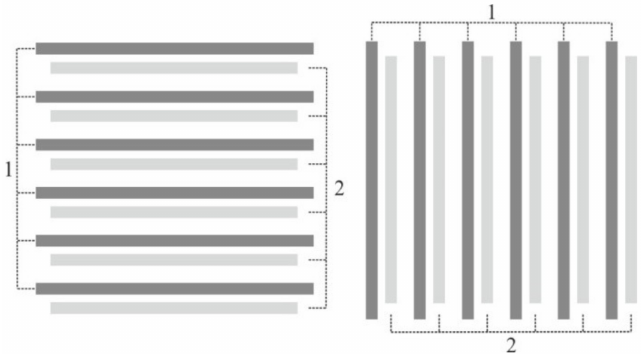
Figure 8. Configuration of twin 1D diffractive sensor